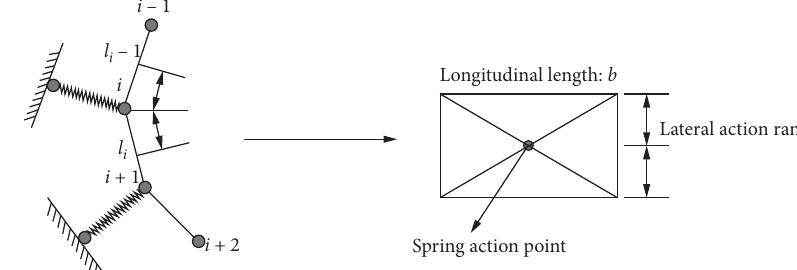
Figure 6: Support range of spring element in local coordinate system.